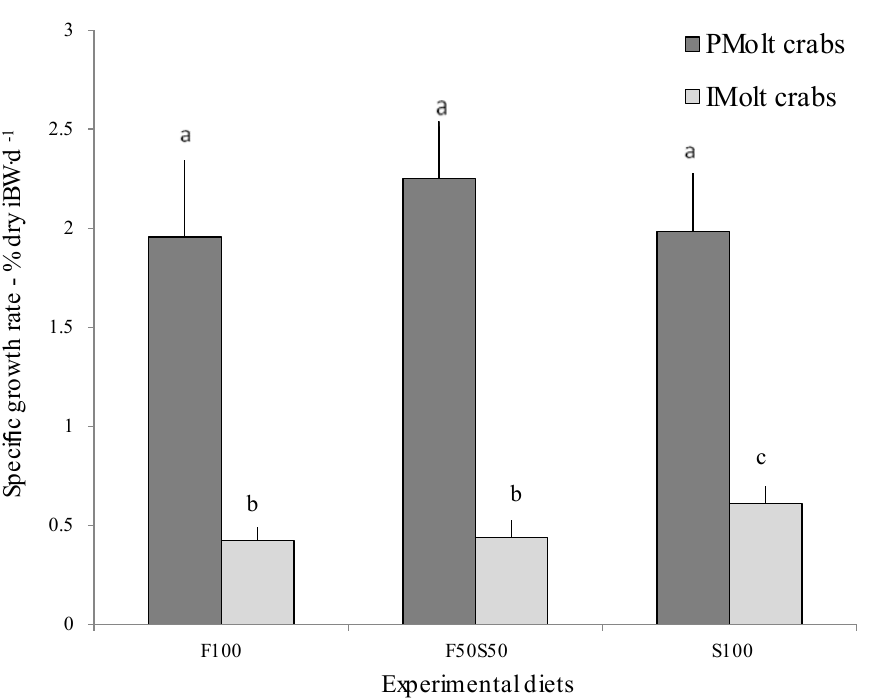
Figure 5. Adjusted mean specific growth rates ( ± SD) for average feed intakes of PMolt and IMolt crabs. Means with different superscript letters differ significantly ( p < 0.05).